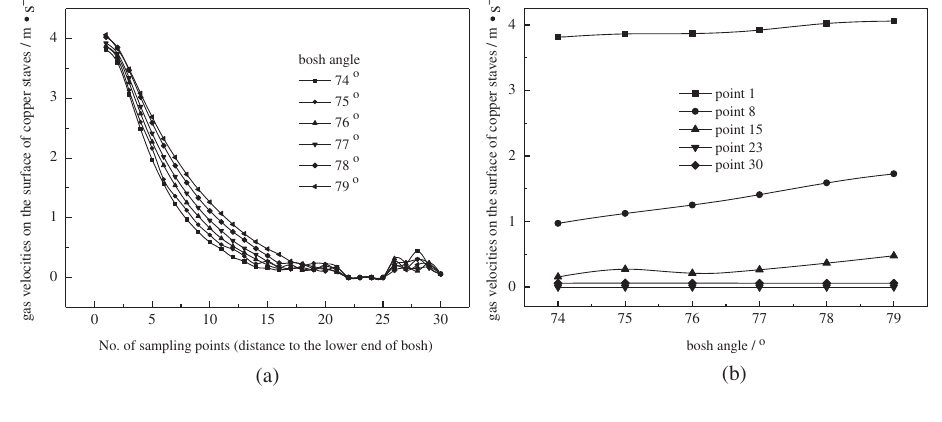
Figure 4: The gas flow veloci- ties at the Bosh area before “ rectifying effect ” under the conditions of different Bosh